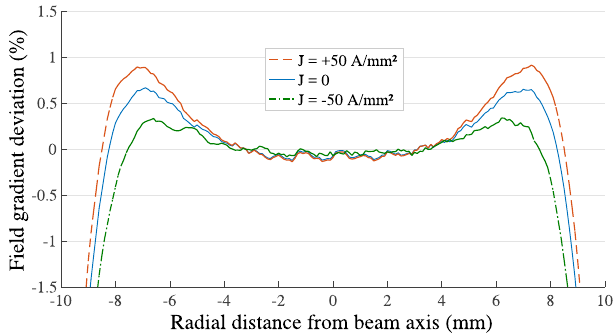
FIG. 11. Radial field gradient deviation in the hybrid design when adjusting excitation current.